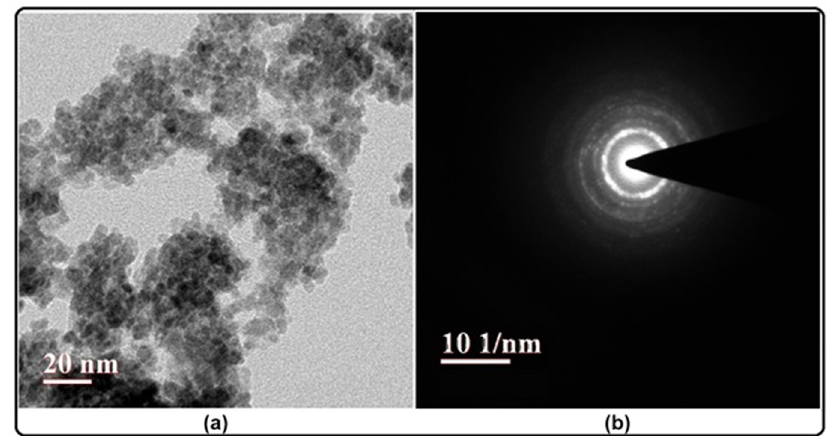
Figure 5: ( a ) TEM image and ( b ) SAED pattern of the biogenic CuO NPs.